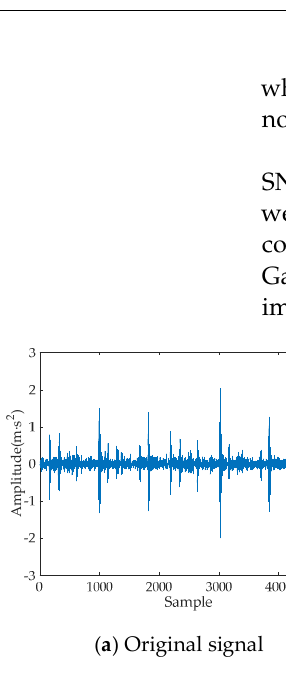
Figure 11. Noise-added vibration signal with SNR = 0 dB.